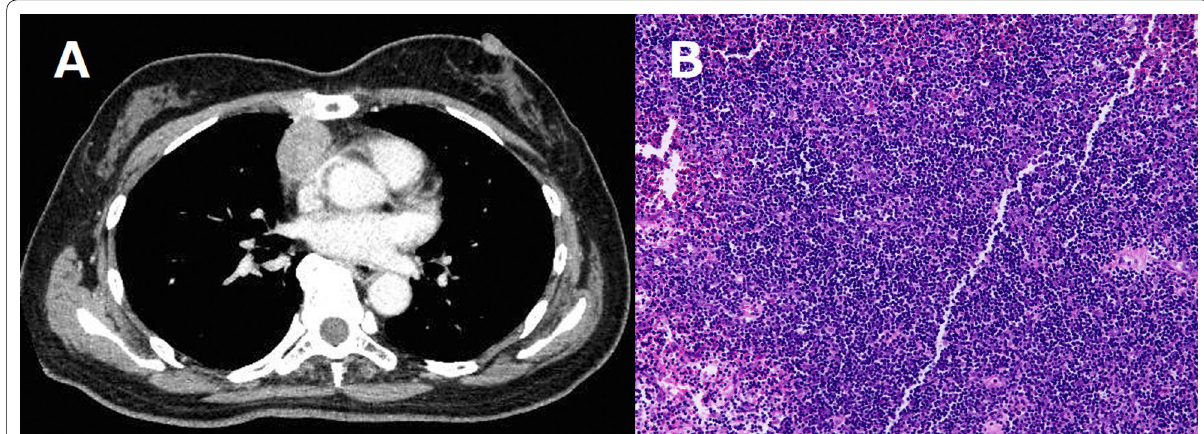
Fig. 1 a Computed tomography findings of the chest showing a 32-mm solid tumor in the anterior mediastinum. b Hematoxylin–eosin staining of the tumor showing that the lymphocytic population obscures the epithelial cells (magnification